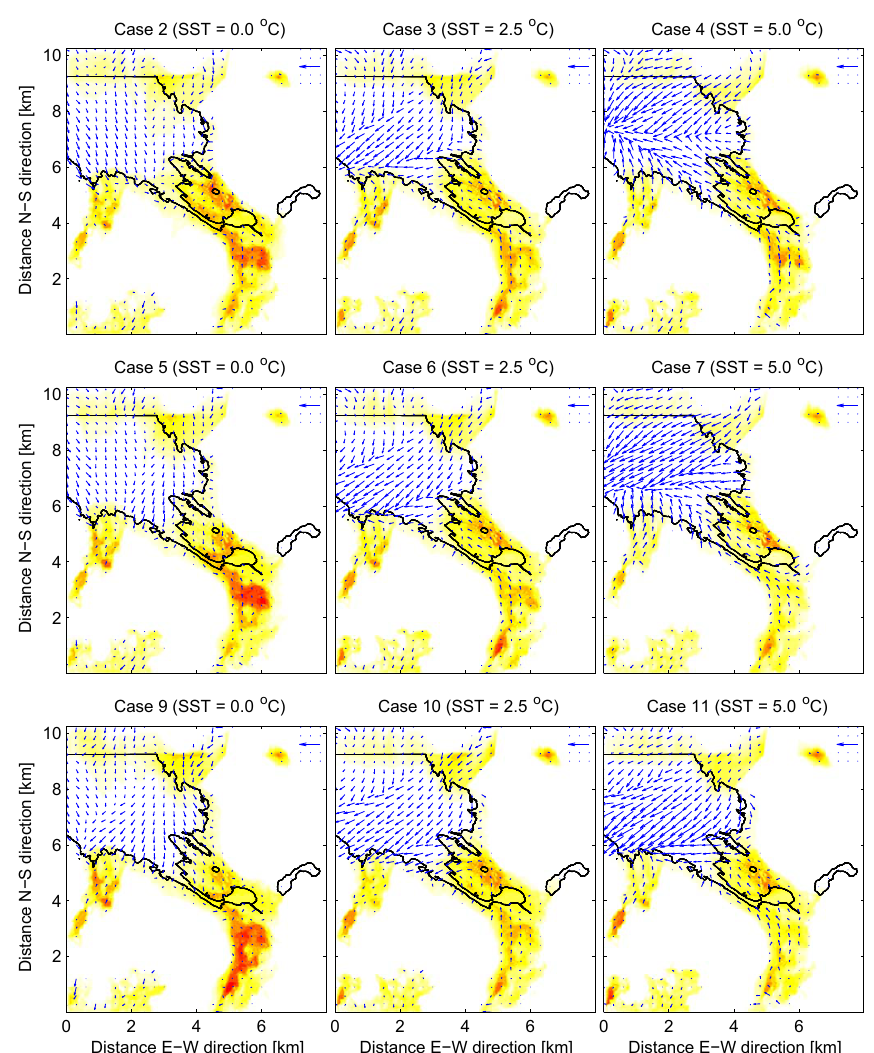
Figure 7. Wind fields at 55m height and passive tracer concentration 2m above the surface. The top, middle, and bottom panels show the results for wind speed scenario 1, 2, and 3, respectively. All data are means over the last four output steps of the 12h simulation. Each output step is an average of 15min. Colour and wind-speed scales are the same in all panels. Darker colour means higher tracer concentrations. The domain is cut off at the right boundary since the topography here was mostly above 55m. The wind vector in the upper right corner indicates a wind speed of 5.2ms − 1 . The water–land interface is shown by the black solid